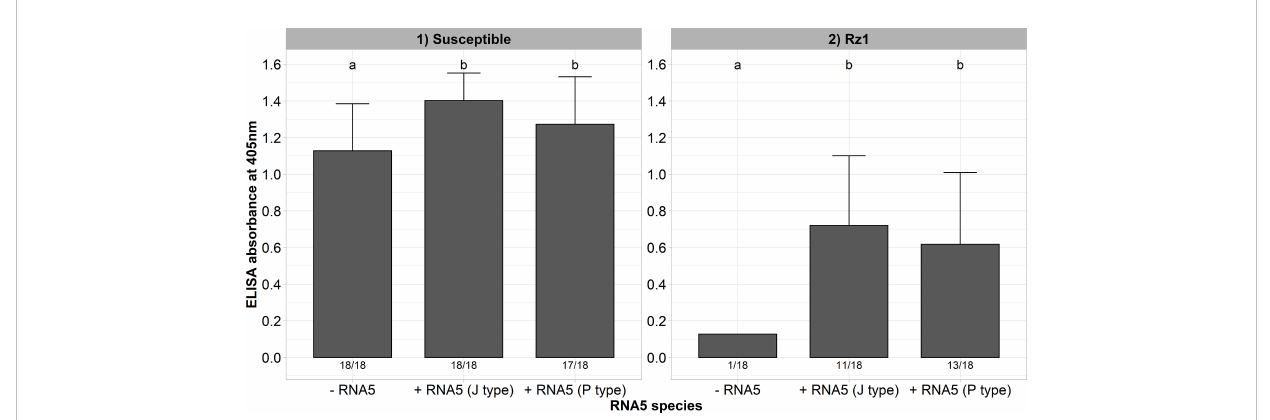
FIGURE 4 ELISA absorbance values for BNYVV measured in lateral roots of plants from a susceptible and Rz1 resistant sugar beet genotype (N=18). The non- resistance-breaking clone with the tetrad ALHG was either inoculated alone (-RNA5) or together with the P or J type RNA5 (+ RNA5). Lateral roots were harvested 6 weeks after infection. The numbers below each bar indicate the infection rate (infected/inoculated). Mean values were calculated using only infected plants, whereas all values were averaged when no plant was infected. Error bars indicate standard deviation. The healthy controls are not shown because the absorbance values were zero. The statistical analysis between tetrad variants was done separately for both genotypes with the Dunnett post hoc test. Signi fi cant differences are indicated by small letters (p <